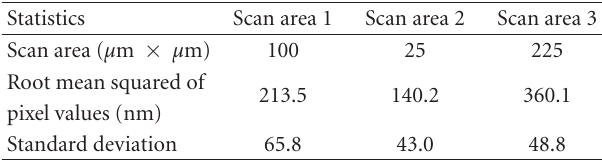
Table 2: AFM statistic results.